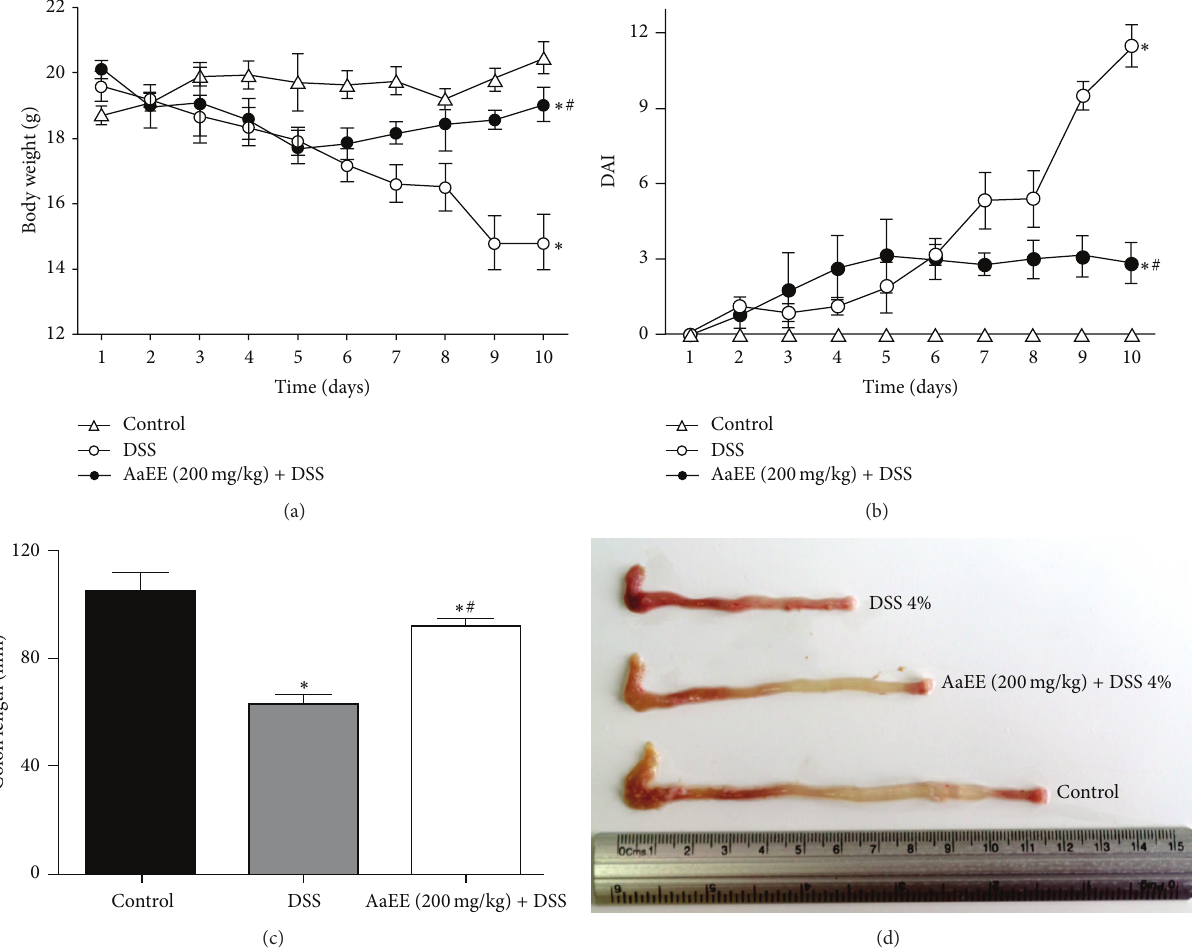
Figure 2: AaEE attenuates clinical signs in mice with DSS-induced colitis. (a) Changes in the body weights and (b) clinical scores of AaEE- treated mice and control mice given 4% DSS were monitored every day. (c) Colons were obtained from mice 10 days after commencement of DSS administration, and their lengths were measured. (d) Macroscopic features of the colons. Control group (without DSS), 4% DSS administration group (DSS), and 4% DSS with V at 200 mg/kg body weight per day. Data shown are from 3 independent experiments and are expressed as mean ± SD ( 𝑛 = 6 per group). ∗ 𝑃 < 0.05 , versus control; # 𝑃 < 0.05 , versus DSS.